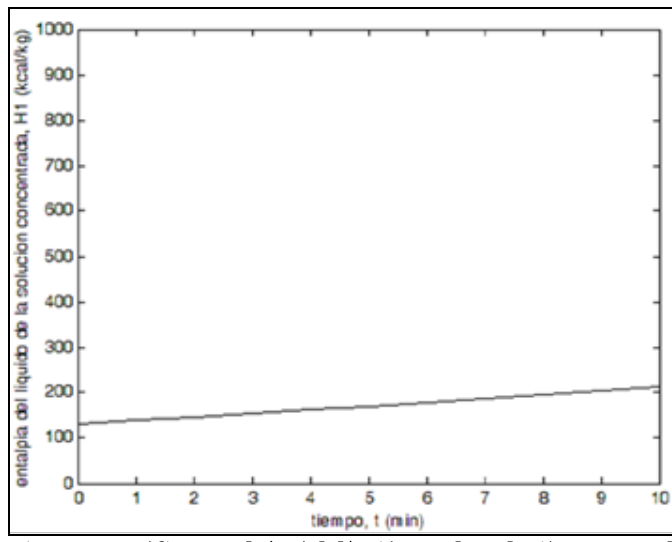
Figura 3: Gráfica entalpía del líquido en la solución contra el tiempo de procesamiento.